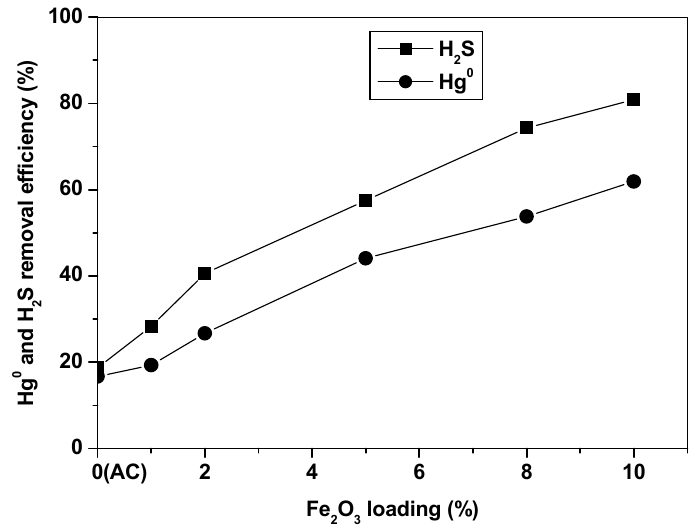
Figure 2. Effect of Fe 2 O 3 loading on Hg 0 and H 2 S removal for 4 h.